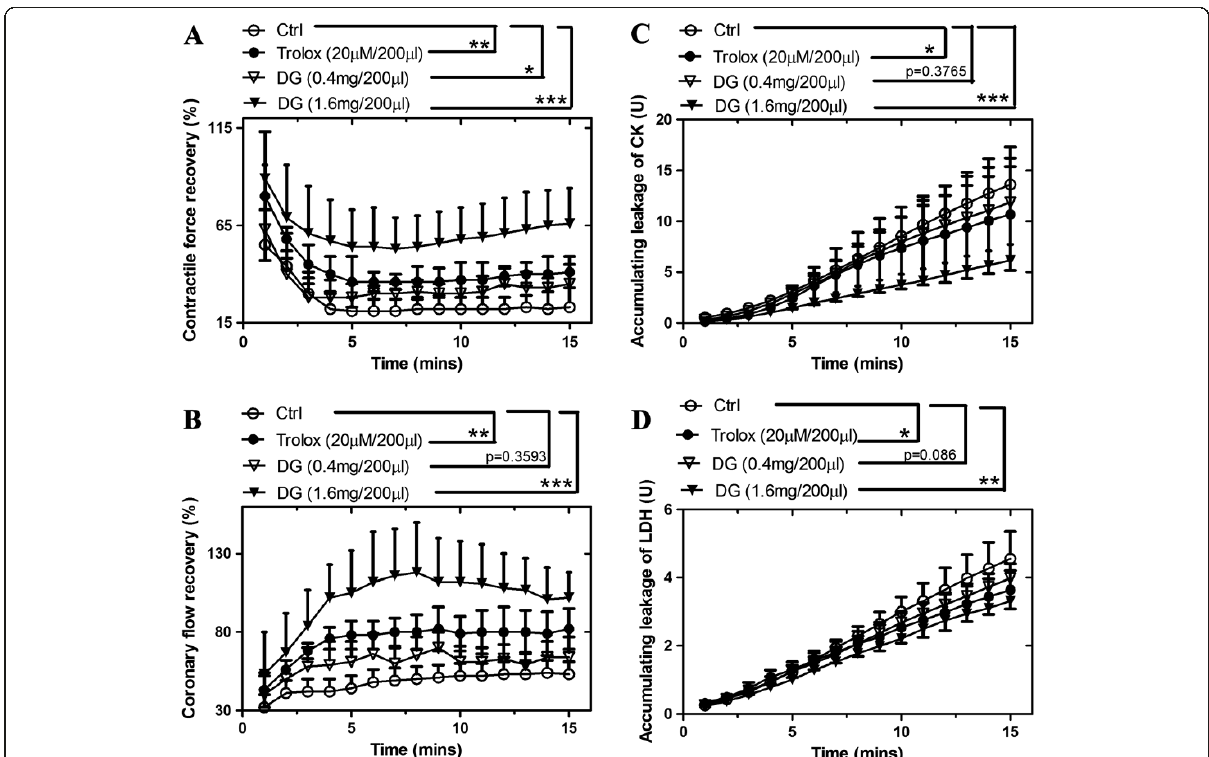
Figure 1 The effects of DG on cardiac function recovery and damage-related enzyme release. A ) The contractile force recovery of an ischemia reperfusion-injured isolated rat hearts was protected by DG. The force recovery of a rat heart in each time point for a rat heart is the ratio of the contractile force at indicated time point to the force before ischemia; B ) The coronary flow rate recovery of an ischemia reperfusion- injured isolated rat hearts was protected by DG. The flow recovery in each time point is the ratio of the flow rate at indicated time point to the rate before ischemia; C ) The accumulating leakage of creatine kinase (CK) of isolated rat hearts was inhibited by DG; D ) The accumulating leakage of lactate dehydrogenase (LDH) of isolated rat hearts was inhibited by DG. Curves were plotted by the mean of 6 rat hearts per group (n = 6). The data were expressed as mean ± S.E.M. *p < 0.05, **p < 0.01 and ***p < 0.001 indicated the groups with significant difference when compared to the control